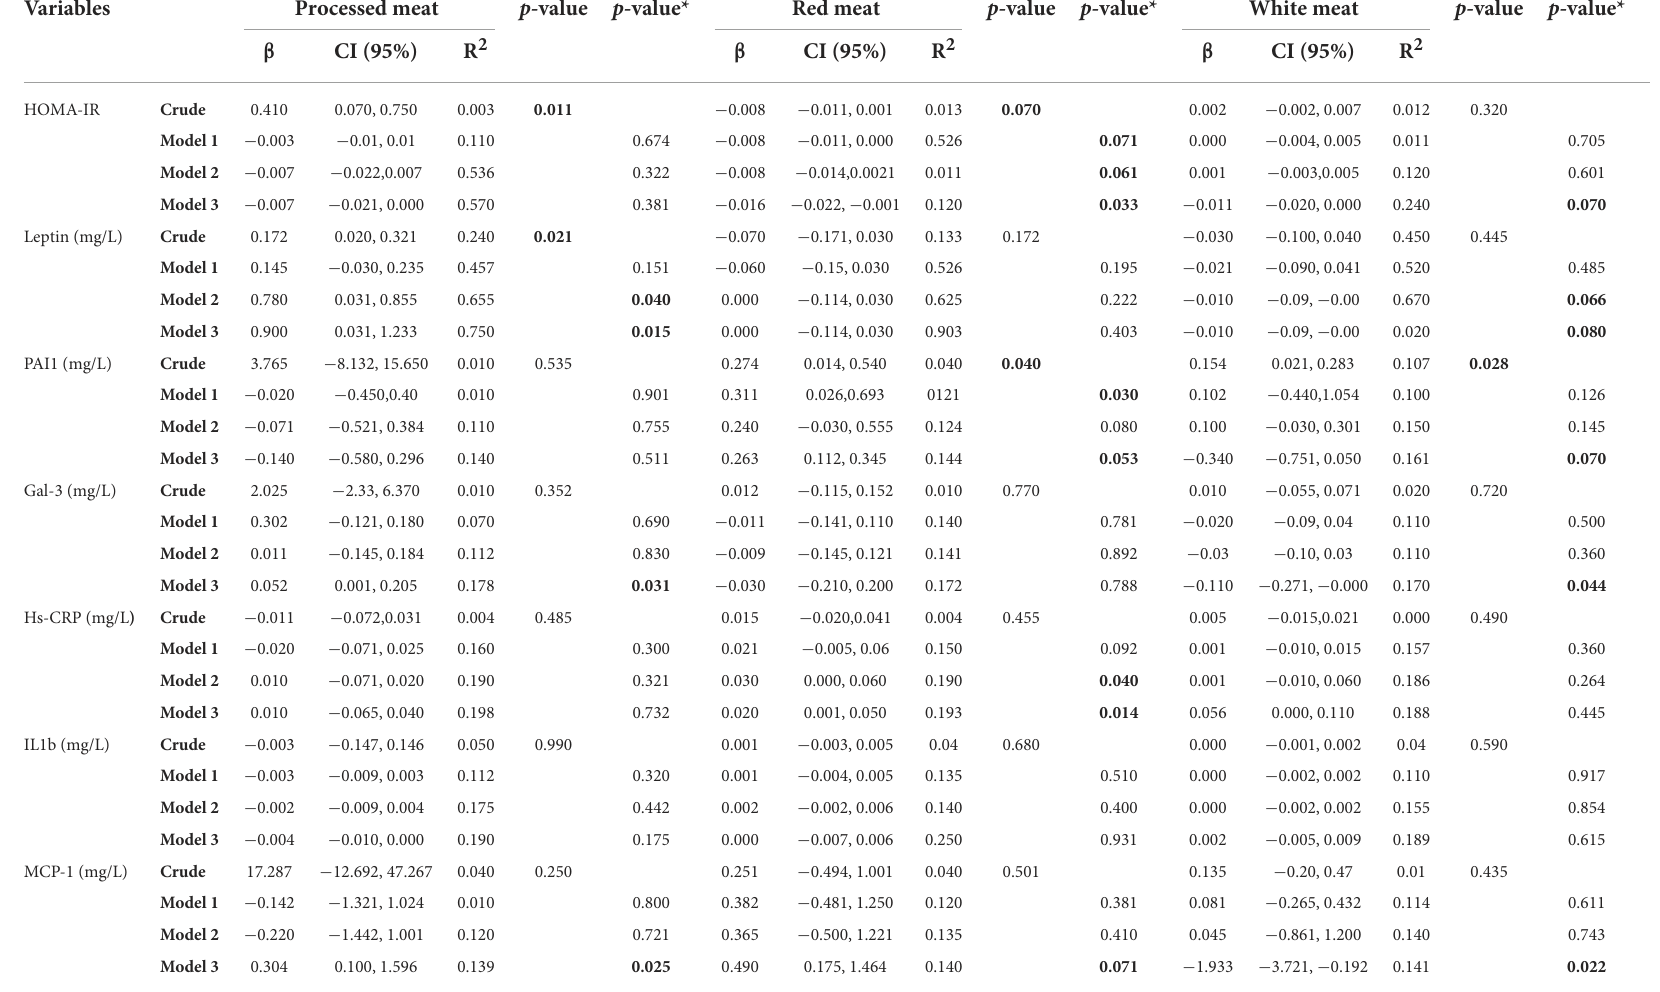
TABLE 4 Association between inflammatory biomarkers with processed meat, red meat, and white meat (g/d) in 391 obese and overweight women.